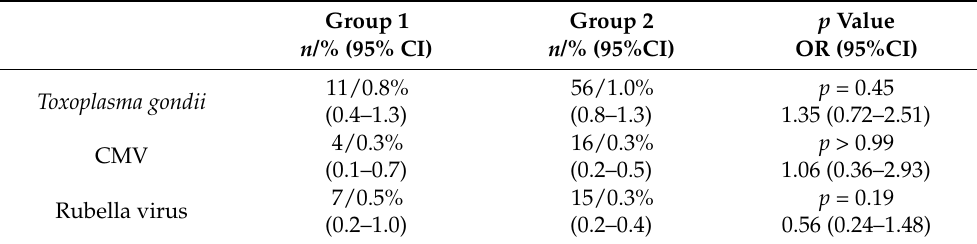
Table 3. Prevalence of women with positive both IgG-and IgM- antibody